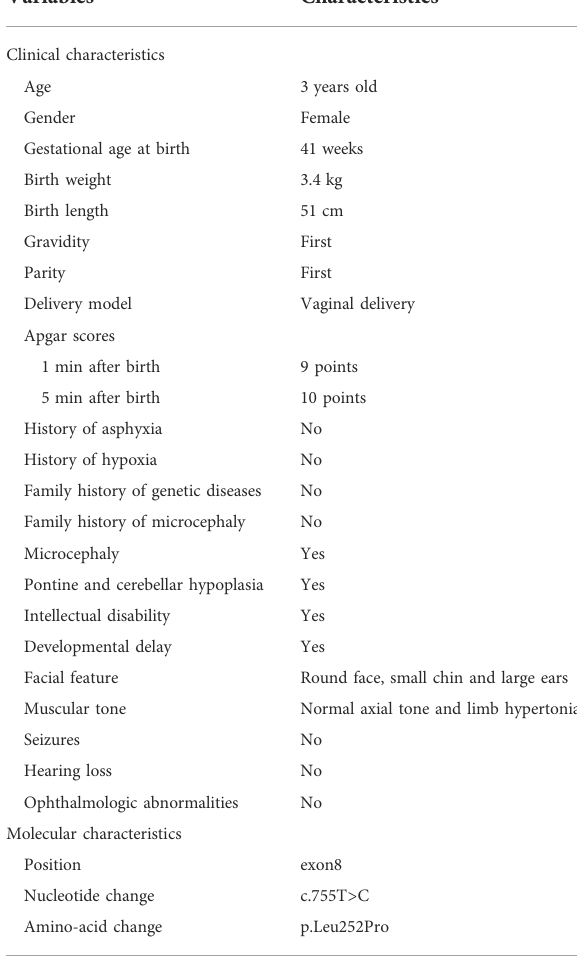
TABLE 1 Clinical and molecular characteristics of the